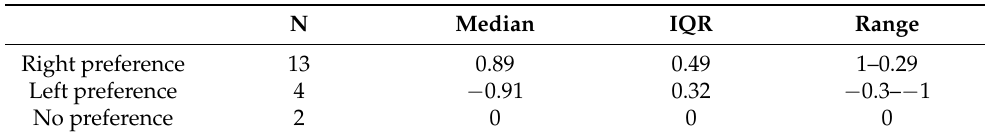
Table 1. Toddler hand preference. Number of toddlers with right and left hand preference with the respective median values, interquartile ranges (IQR) and minimum/maximum values (Range) of the Lateralized manipulation score. N Median